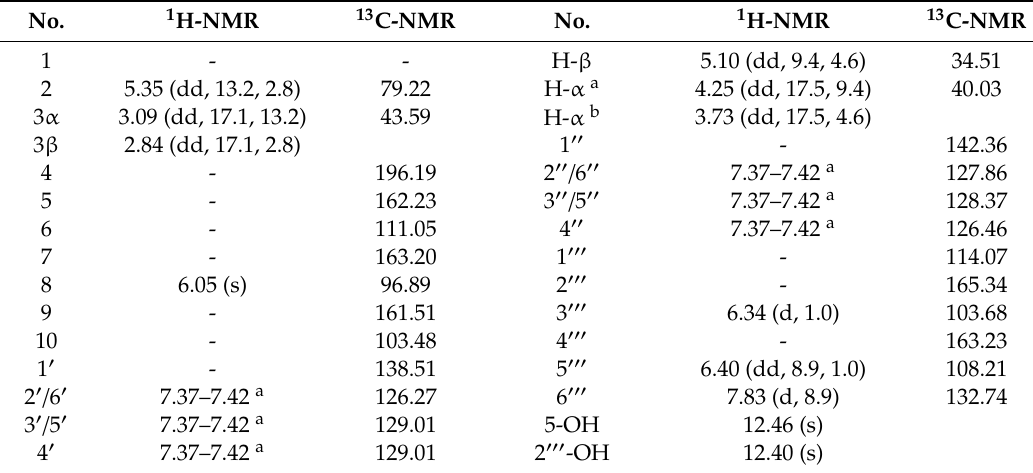
Table 2. 1 H-NMR (500 MHz) and 13 C-NMR (125 MHz) data for oxytrochalcoflavanones A ( 2 ) and B ( 3